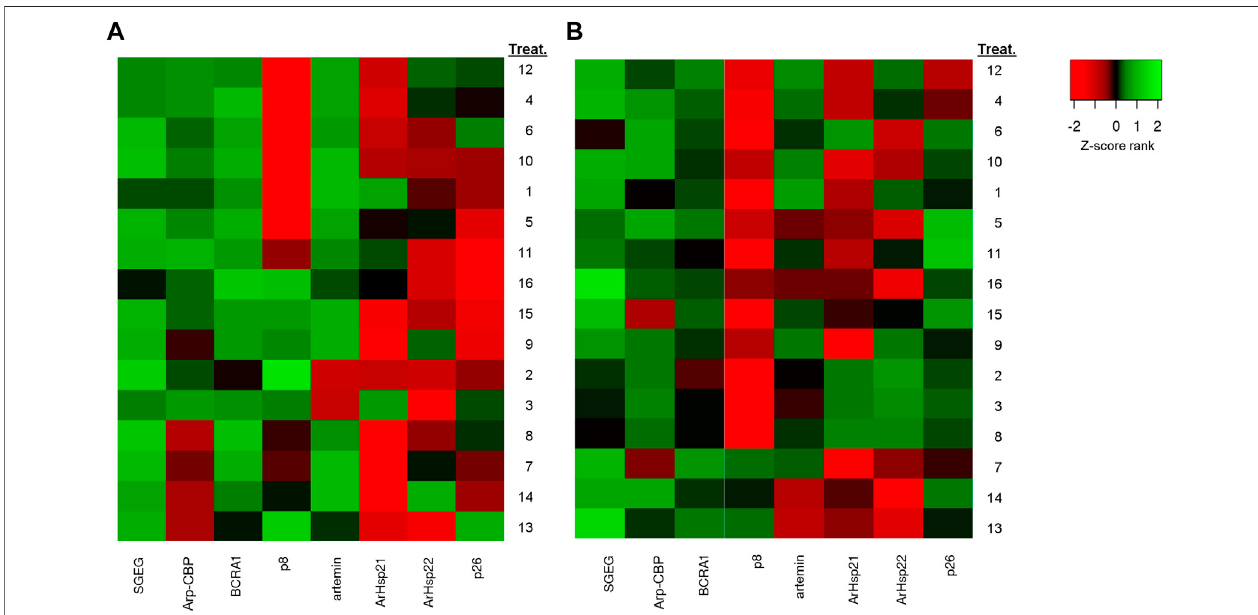
FIGURE3| Thedifferentialgeneexpressionanalysisof Artemiafranciscana .Heatmapofthedifferentialgenesbetween16treatmentsbasedonfoldchangevalues. (A) Barro Negro population (BNE) and (B) San Francisco Bay population (SFB). Red denotes downregulated expression, and green denotes upregulated expression. Treatment numbers are the same as those indicated in Table 2 . To construct the heatmap, differences in the expression level of the genes were assessed after fi rst normalizing expression level to those of β -actin , followed by log transformation (Log 2 ).